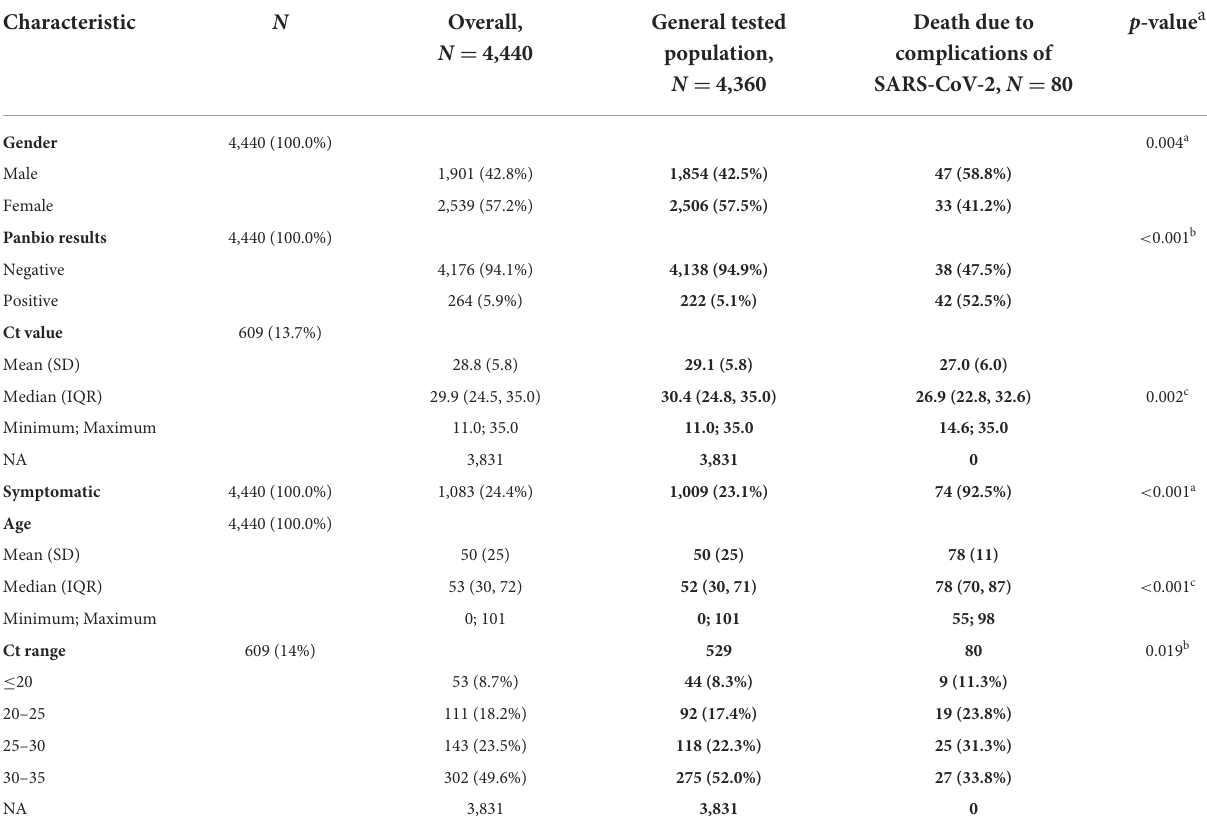
TABLE 8 Comparison of the general tested population with fatal cases. Characteristic N Overall,